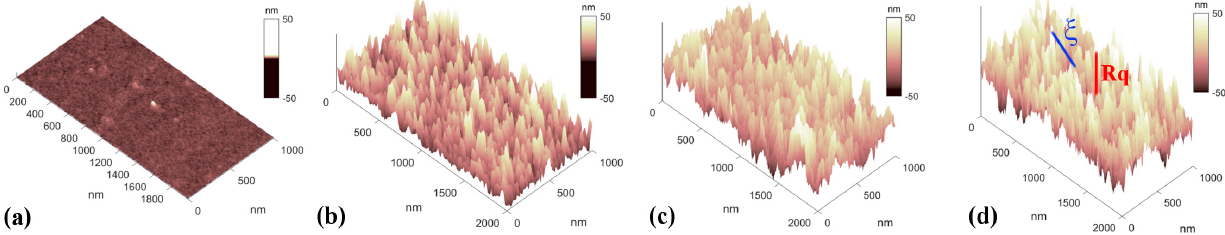
Figure 1. Four 3D AFM images of the glass substrate ( a ) and of the nanostructured zirconia surfaces with increasing roughness (( b – d ), from 10 nm to 20 nm). The morphological parameters calculated by the height maps, i.e., surface roughness (Rq) and correlation length ( ξ ), have been schematically indicated by the red and blue lines.